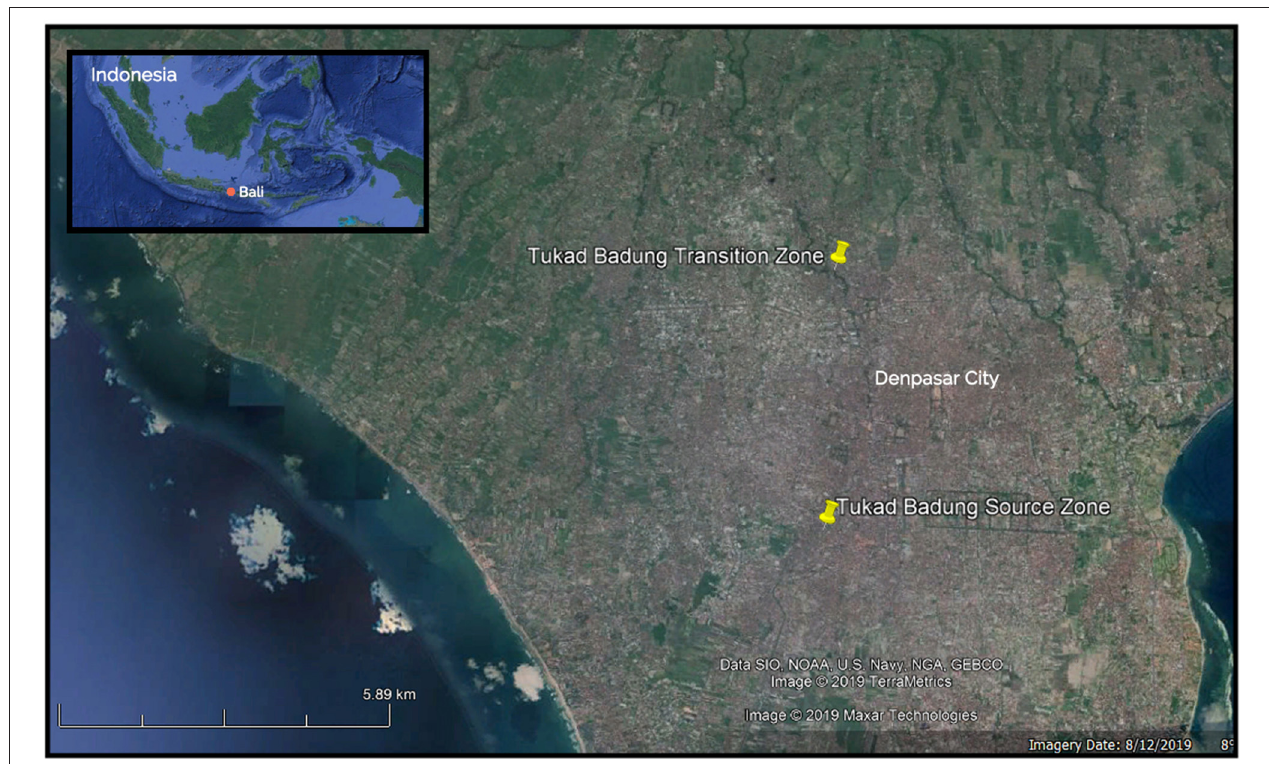
FIGURE 4 | Map of Indonesian sites (Map by P. Kamil).